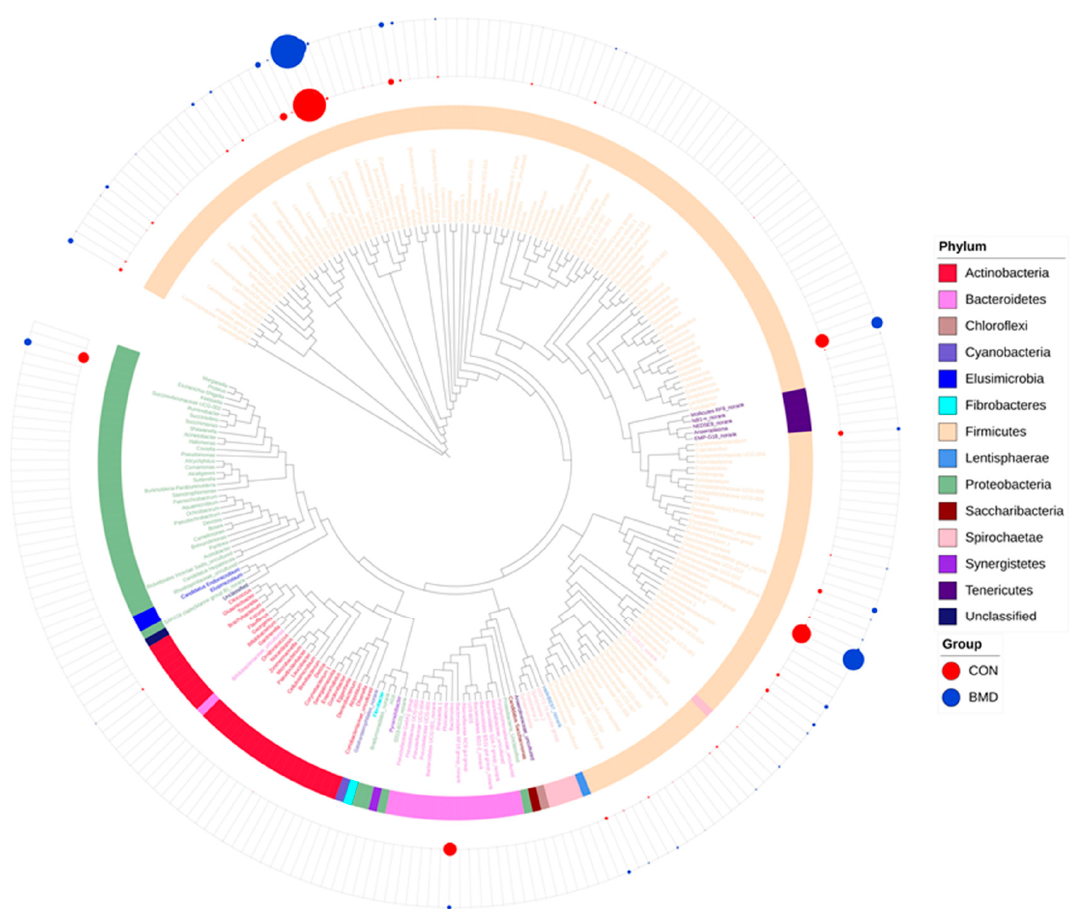
Figure 3. In the caecum of broilers, we found phylogenetic trees of the common bacteria. In the phylogenetic tree, the shape plot on the outermost circle was made according to the T-score; the dark orange and green solid circles represent the high and low groups, respectively; the size of the dot was determined by the value of the T-score; and the coloured strips and labels were coloured according to the phylum.